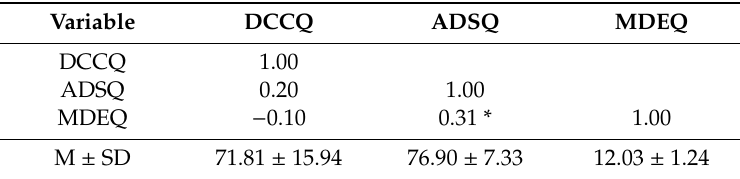
Table1. Relationshipsbetweendisasternursingcompetence, anticipatorydisasterstress, andmotivation for disaster engagement.